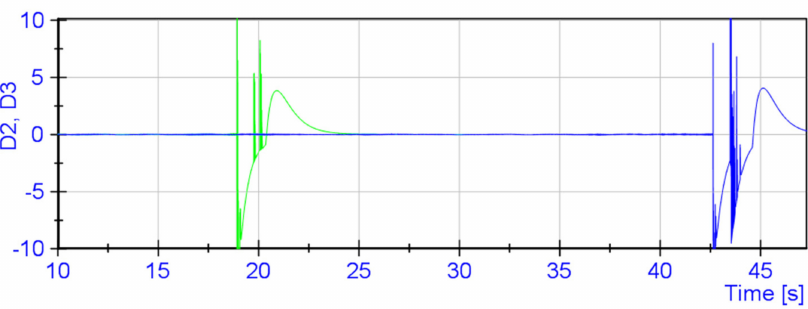
Figure 14. Records from accelerometers D2 and D3.